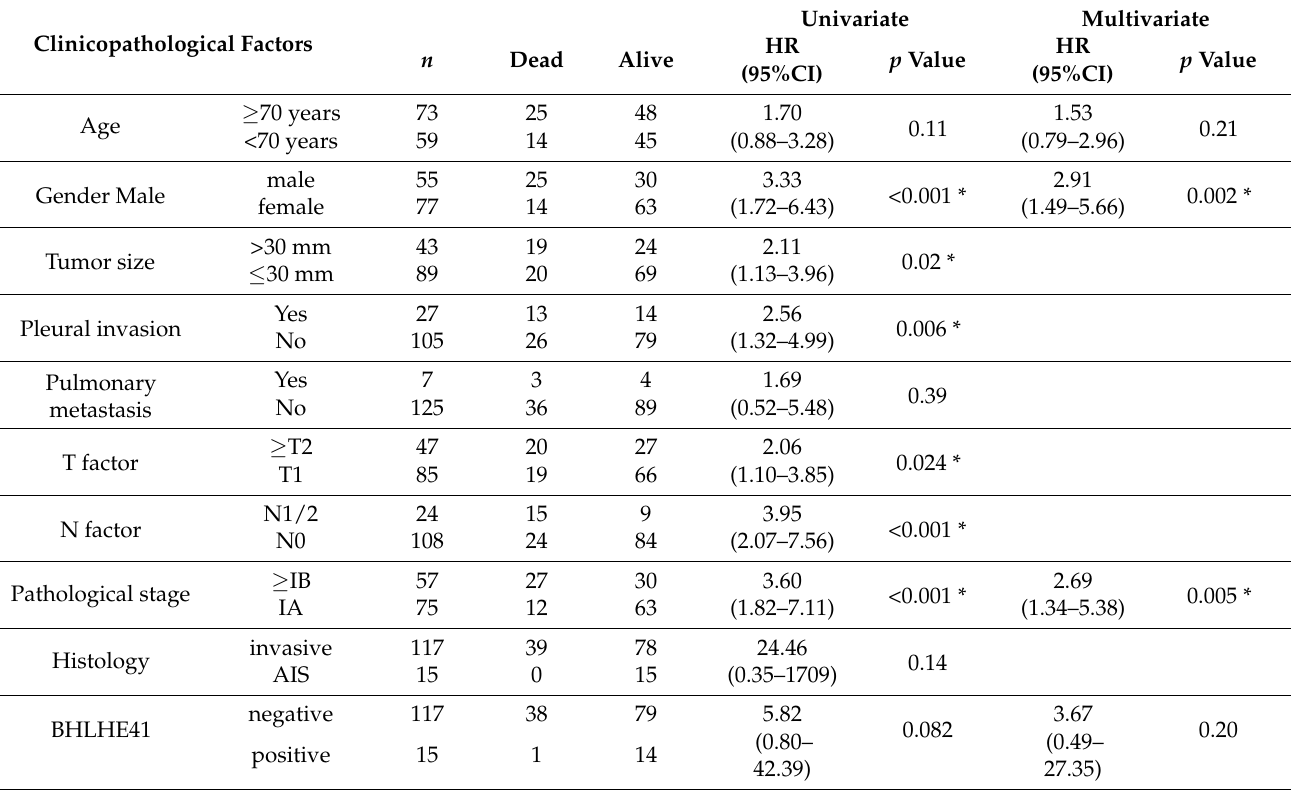
Table 3. Univariate and multivariate COX regression analysis in the patients with LUAD for overall survival. Clinicopathological